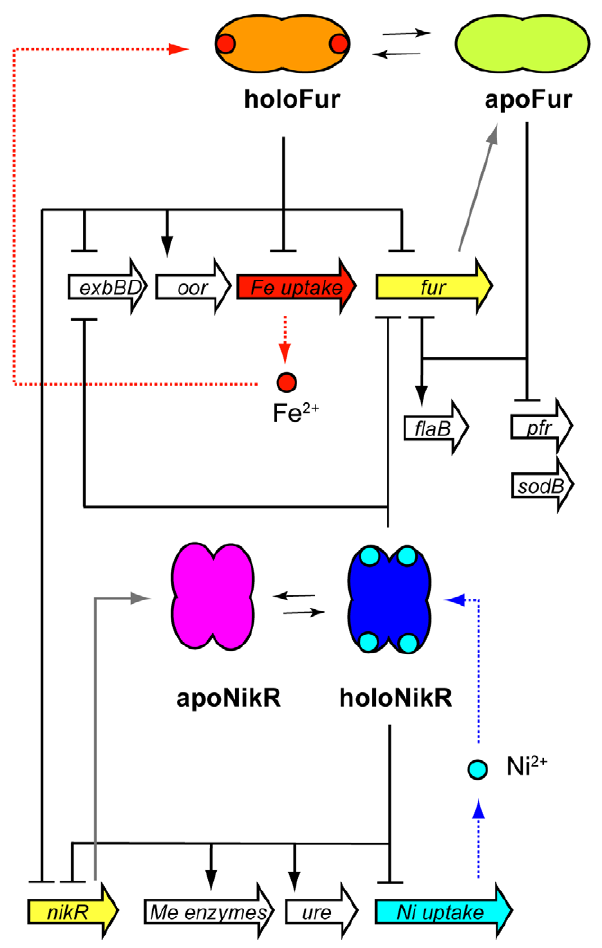
Figure 4. The metal homeostasis origon. Fur regulates transcrip- tion of metal transporters and siderophores (e.g., frpB and fecA paralogues), which need to be repressed upon iron repletion [66–68], as well as detoxifying genes that need to be promptly derepressed under the same Fe 2 + replete conditions (e.g., pfr bacterioferritin and sod superoxide dismutase) [69,70]. Fur generally acts as repressor, but it may also act positively on transcription on certain genes ( flaB , oor ) [74]. Similarly, NikR can act as positive or negative regulator of transcription, according to the position of the operator elements [79,80]. With respect to the promoter, binding upstream appears to induce transcription of the ureAB operon in cultures grown in Ni 2 + replete cultures [64]. Conversely, binding within the core promoter represses transcription, as shown for the fecA3 and frpB4 genes, encoding outer membrane proteins [68,103,105], the nixA permease gene [106], and the exbBD- tonB operon, that is involved in energization of outer membrane transport complexes involved in metal uptake [107], and itself part of the Fur regulon [74,75,81,104]. Note that both Fur and NikR are autoregulated, and that they control reciprocally their transcription levels, through direct binding to their respective promoters [81]. Several operons such as exbBD-tonB are under the control of both Fur and